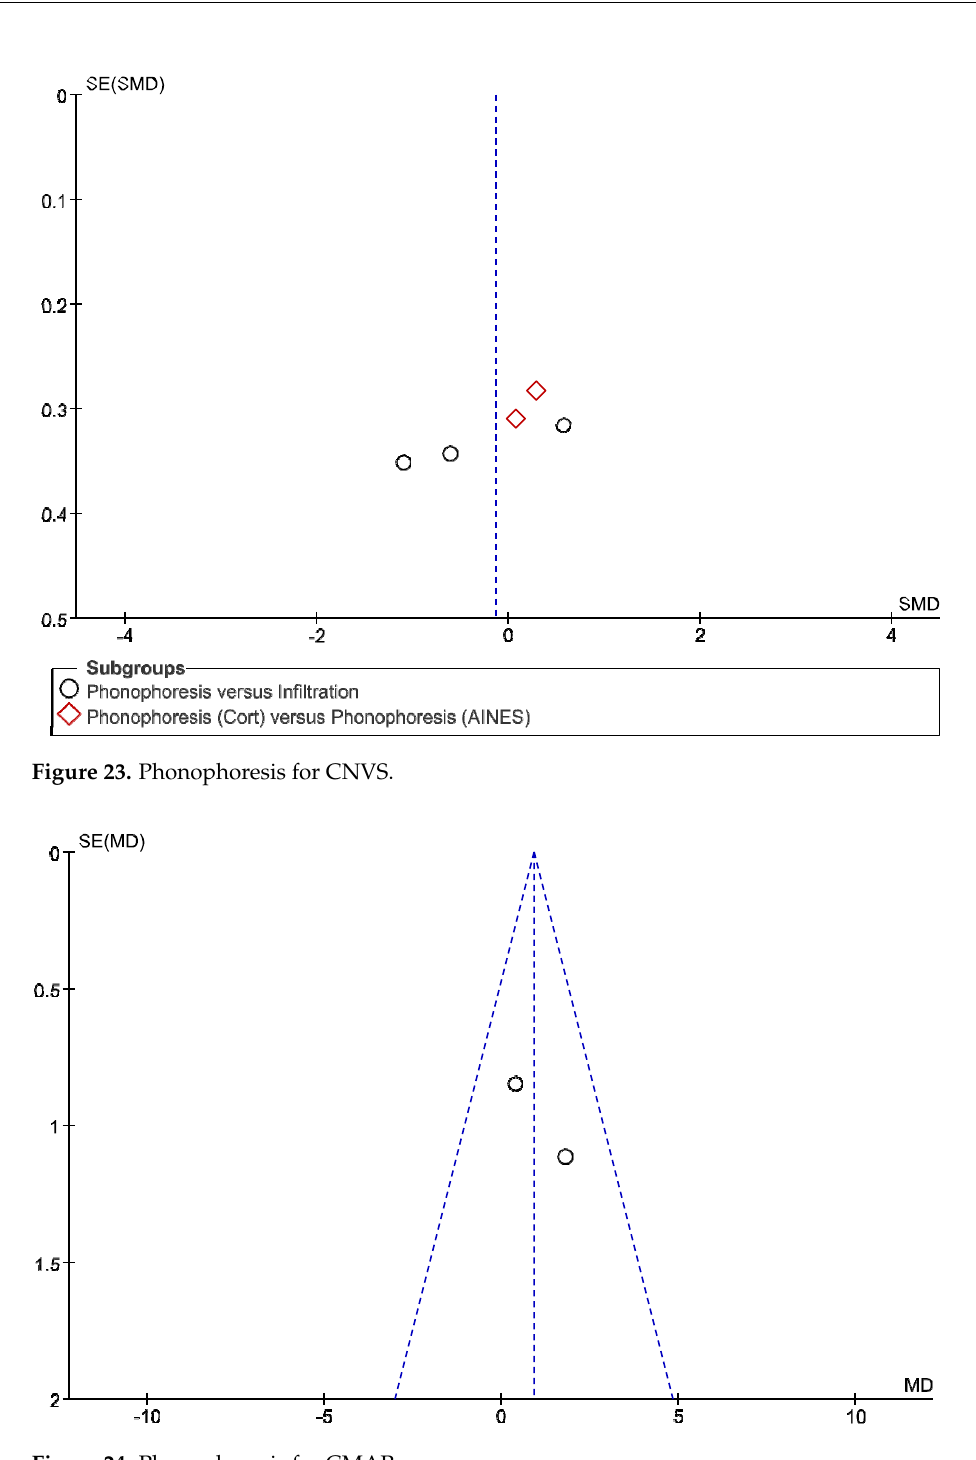
Figure 24. Phonophoresis for CMAPam.